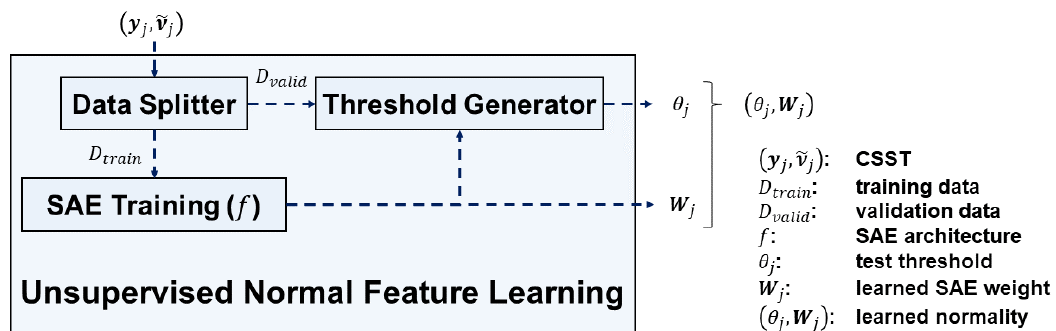
Figure 6. The unsupervised normal feature learning module in STALAD.